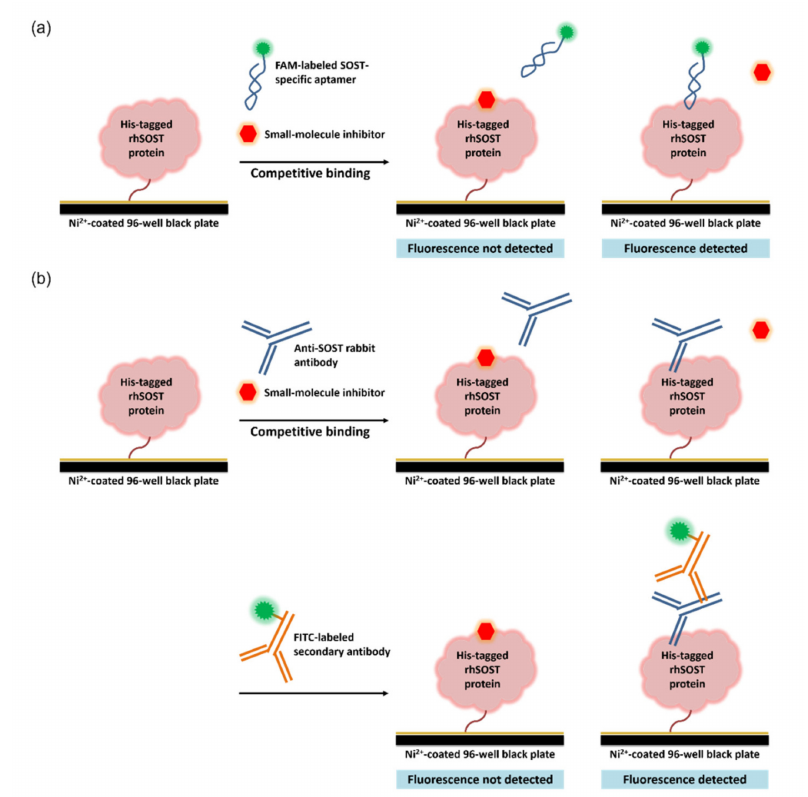
Figure 2. Aptamer-based and antibody-based competitive assays for small-molecule drug screening. The assay platforms were constructed by immobilizing His-tagged recombinant human sclerostin on a nickel-coated surface, followed by reacting with small-molecule compounds as potential